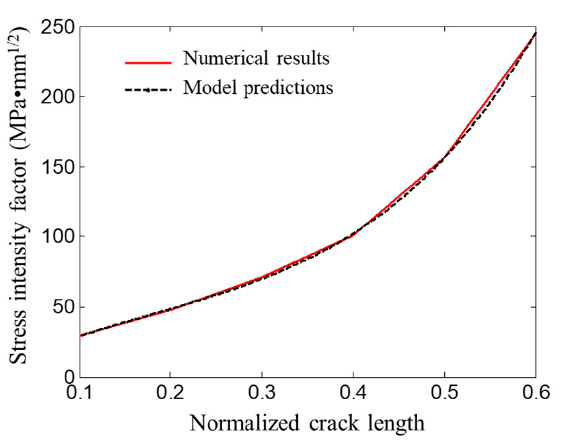
Figure 6. Comparison between numerical results and model predictions under load of 200 MPa.